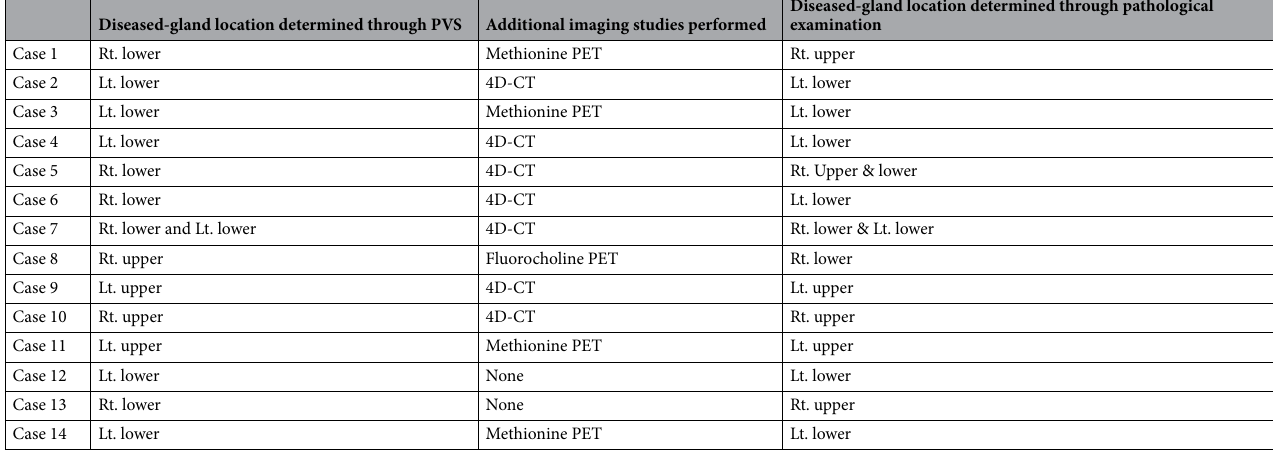
Table 3. Detailed description of postoperative localisation through PVS and results of pathological examinations (for the negative group). All results of additional imaging studies were ambiguous. PVS: parathyroid venous sampling; PET: positron emission tomography; 4D-CT: four-dimensional computed tomography; Rt.: right; Lt.: